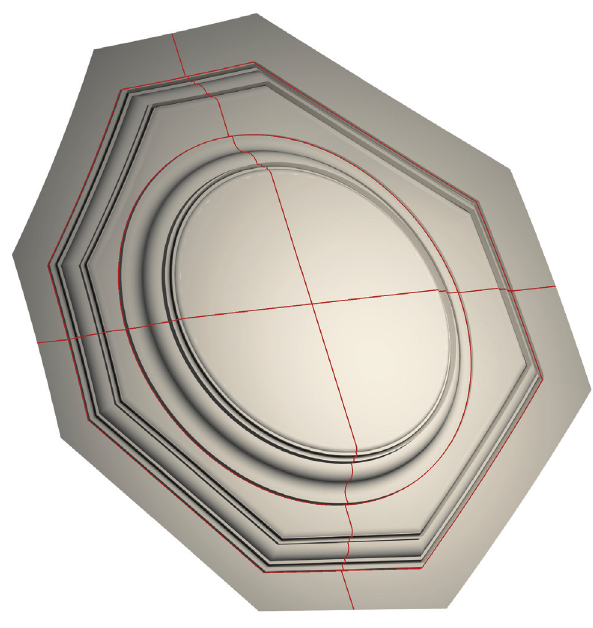
Figure 11. The San Carlo vault coffer. The 3d model creation is more complex, because it’s made by an extrusion of section on two different paths: an octagon projected on a mathematical model of the surface (Canciani, et al., 2012) and a circular